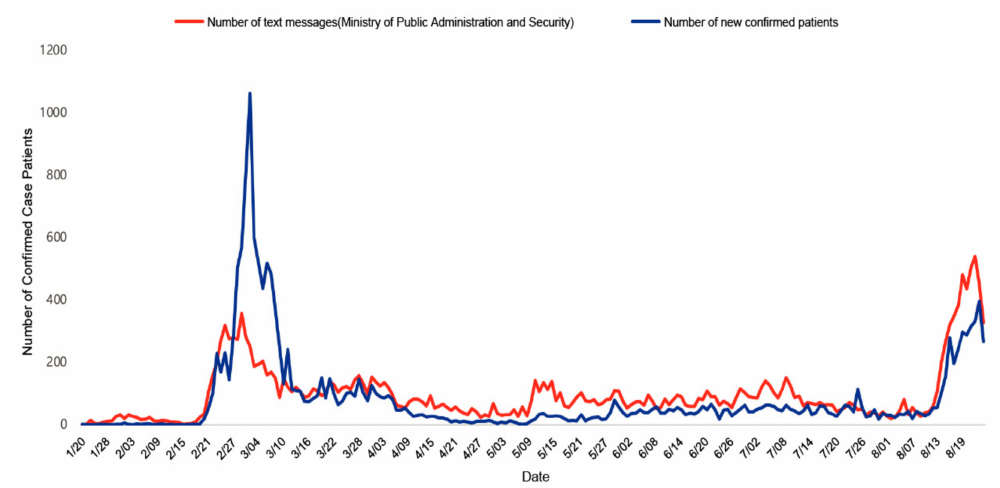
Figure 2. Analysis of the number of new cases of COVID-19 in South Korea in